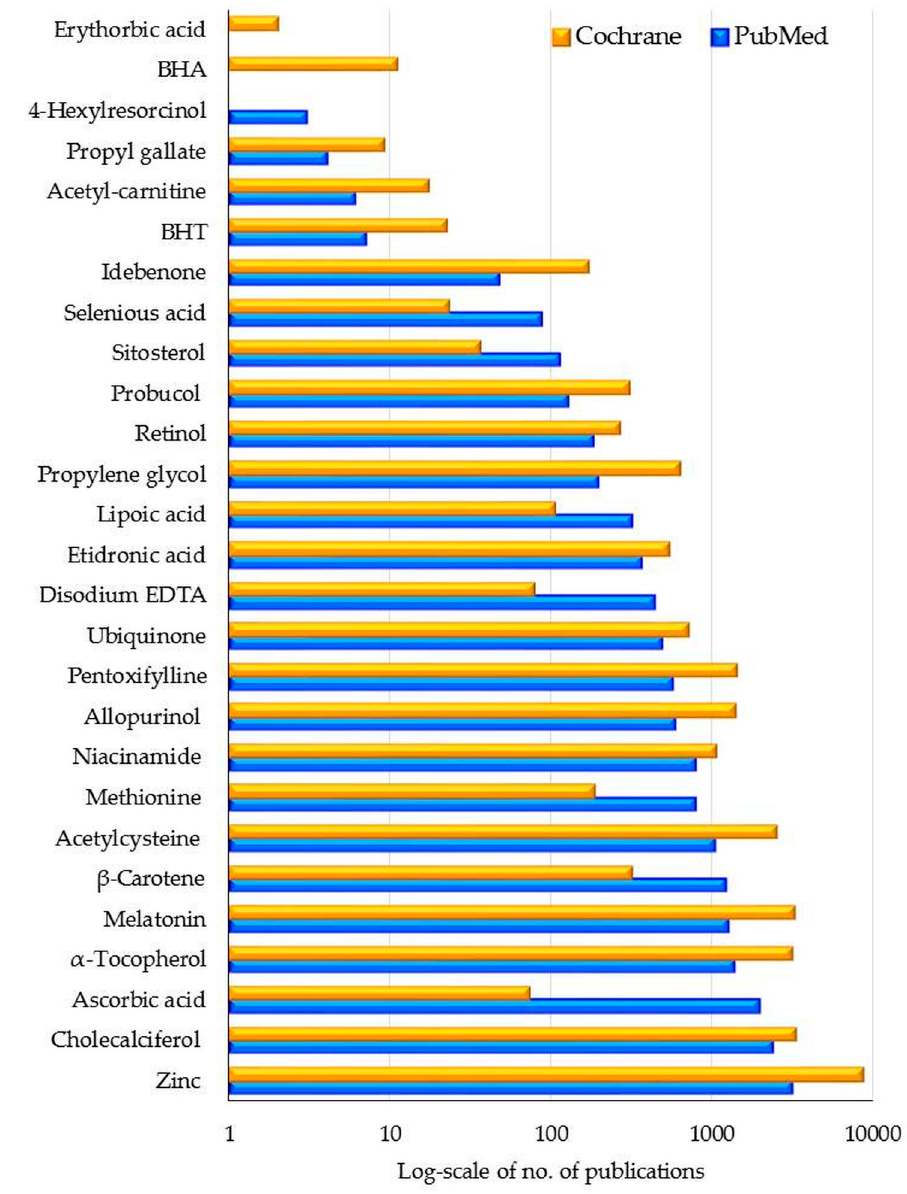
Figure 4. The number of publications on synthetic antioxidants as resulted from the bibliometric analysis of systematic reviews and randomized clinical trials using Cochrane Library and PubMed database (log-scale plot).